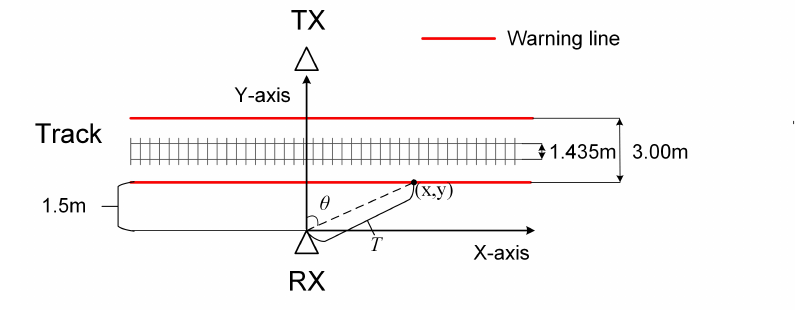
Figure 7. Pseudo spectrum of the foreign object detection and localization algorithm. ( a ) Without static clutter suppression. ( b ) With static clutter suppression.